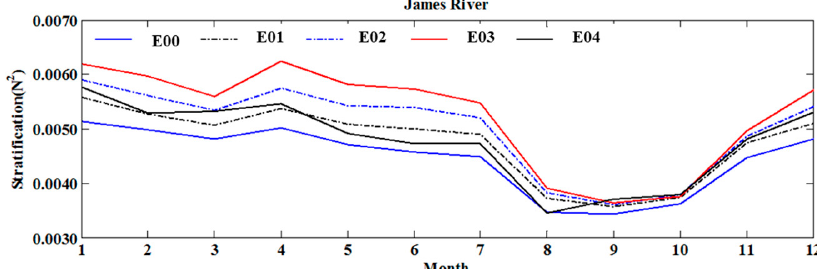
Figure 4. Variation of the seasonal mean salinity stratification strength (maximum N 2 in s − 2 ) with respect to channel deepening and sea-level rise.